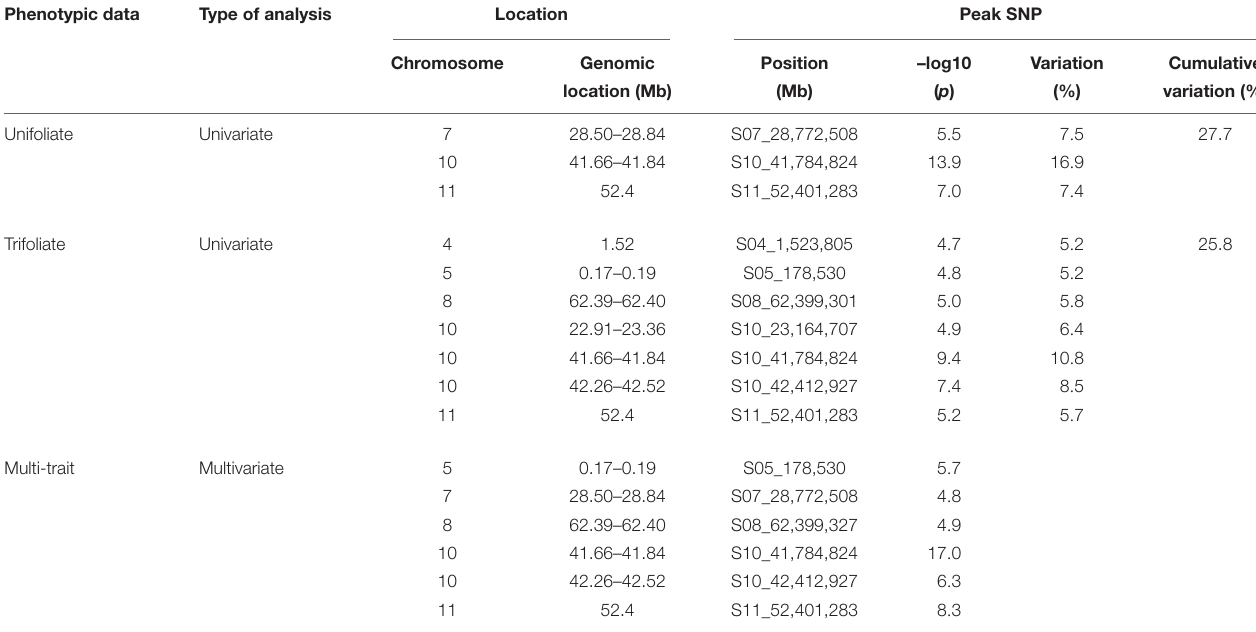
TABLE 3 | GEMMA GWAS results for phenotypic traits in the Middle American breeding population. Phenotypic data Type of analysis